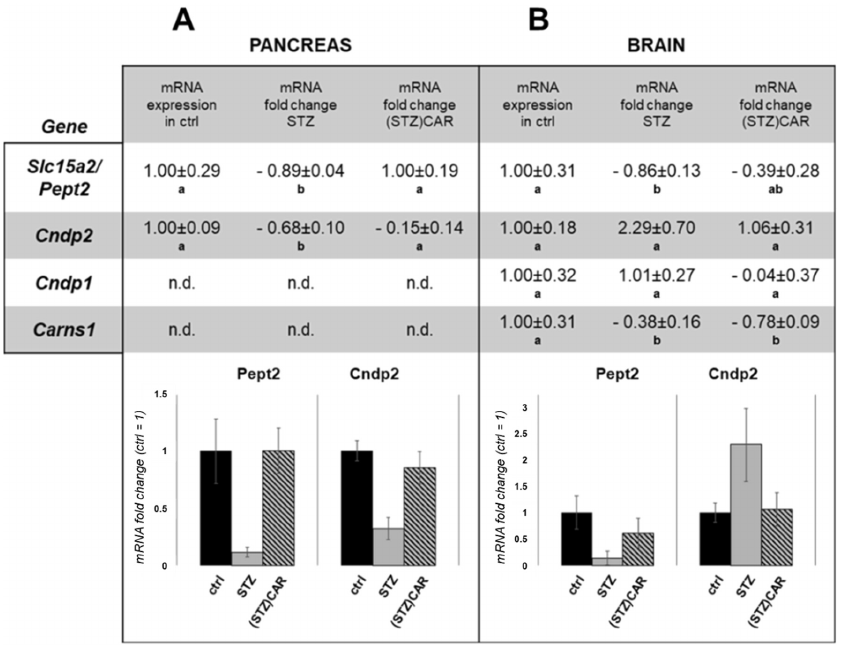
Figure 3. qPCR analysis of the mRNAs of genes related to CAR homeostasis ( Slc15a2 / Pept2 , Cndp2 , Cndp1 and Carns1 ), in the pancreas ( A ) and brain ( B ) of hyperglycemic mice undergone STZ treatment. Ctrl: untreated control mice; STZ: hyperglycemic mice; (STZ)CAR: hyperglycemic mice orally administered with CAR. Each mRNA target expression derives from the value of the 2 −Δ C t function ( C t , Threshold cycle) normalized respect to the 28S RNA [25]. n.d.: not detected mRNA expression. Histograms below emphasize the expression variations for the two mRNAs found in both tissues (i.e., Slc15a2/Pept2 and Cndp2). Values are expressed as fold change with respect to